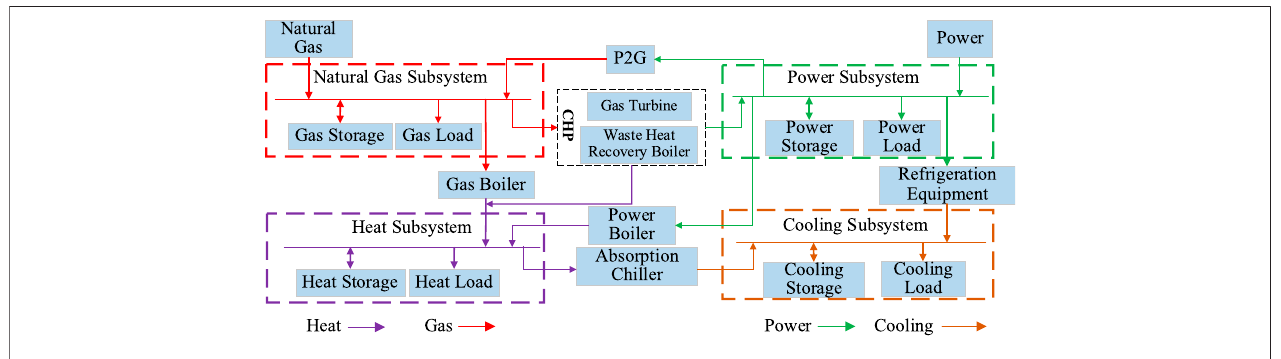
FIGURE 1 | The structure of the integrated energy